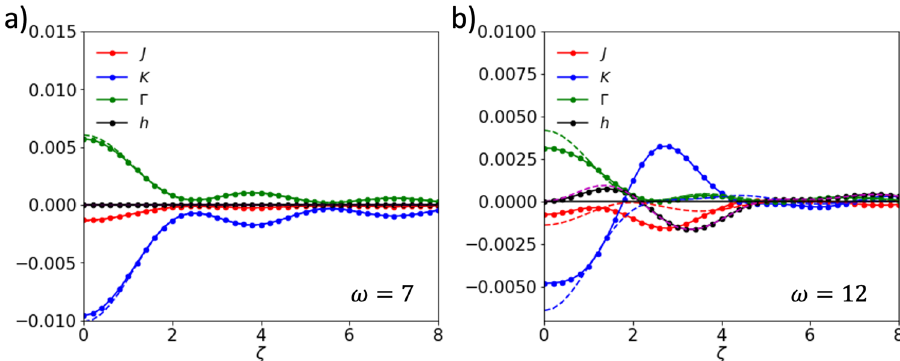
Fig. 5 Comparison of the exact diagonalization (ED) and perturbation theory results. a The result for the case without ligand at drive frequency ω = 7. b The comparison in the model with ligands at ω = 12. The solid(dashed) lines represent the numerical(analytical) results, respectively, in the respective color, except the analytical result for magnetic fi eld ( h ) which is shown in the magenta dashed